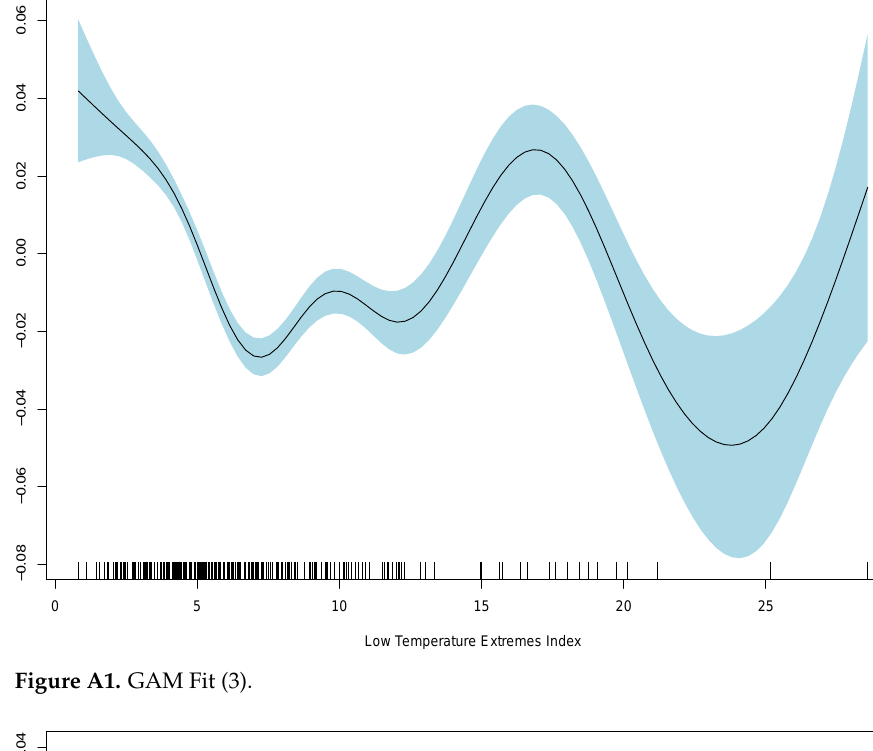
Figure A1. GAM Fit (3).